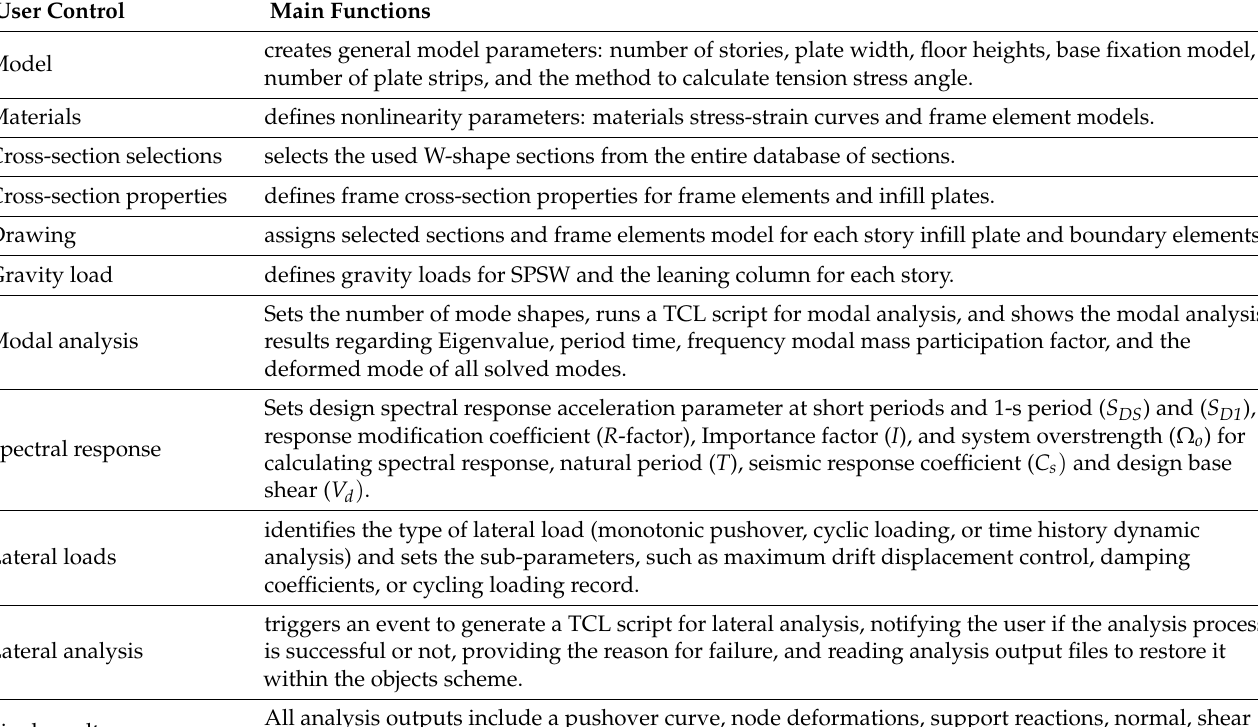
Table 1. The primary user controls for